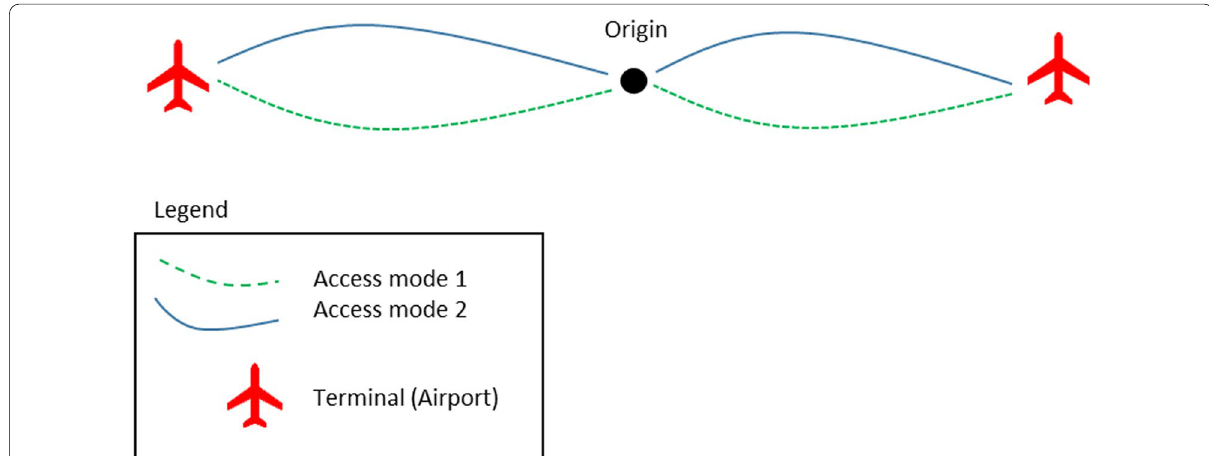
Fig. 3 Schematic figure of stand-alone joint terminal and access mode choice models (Type 3)